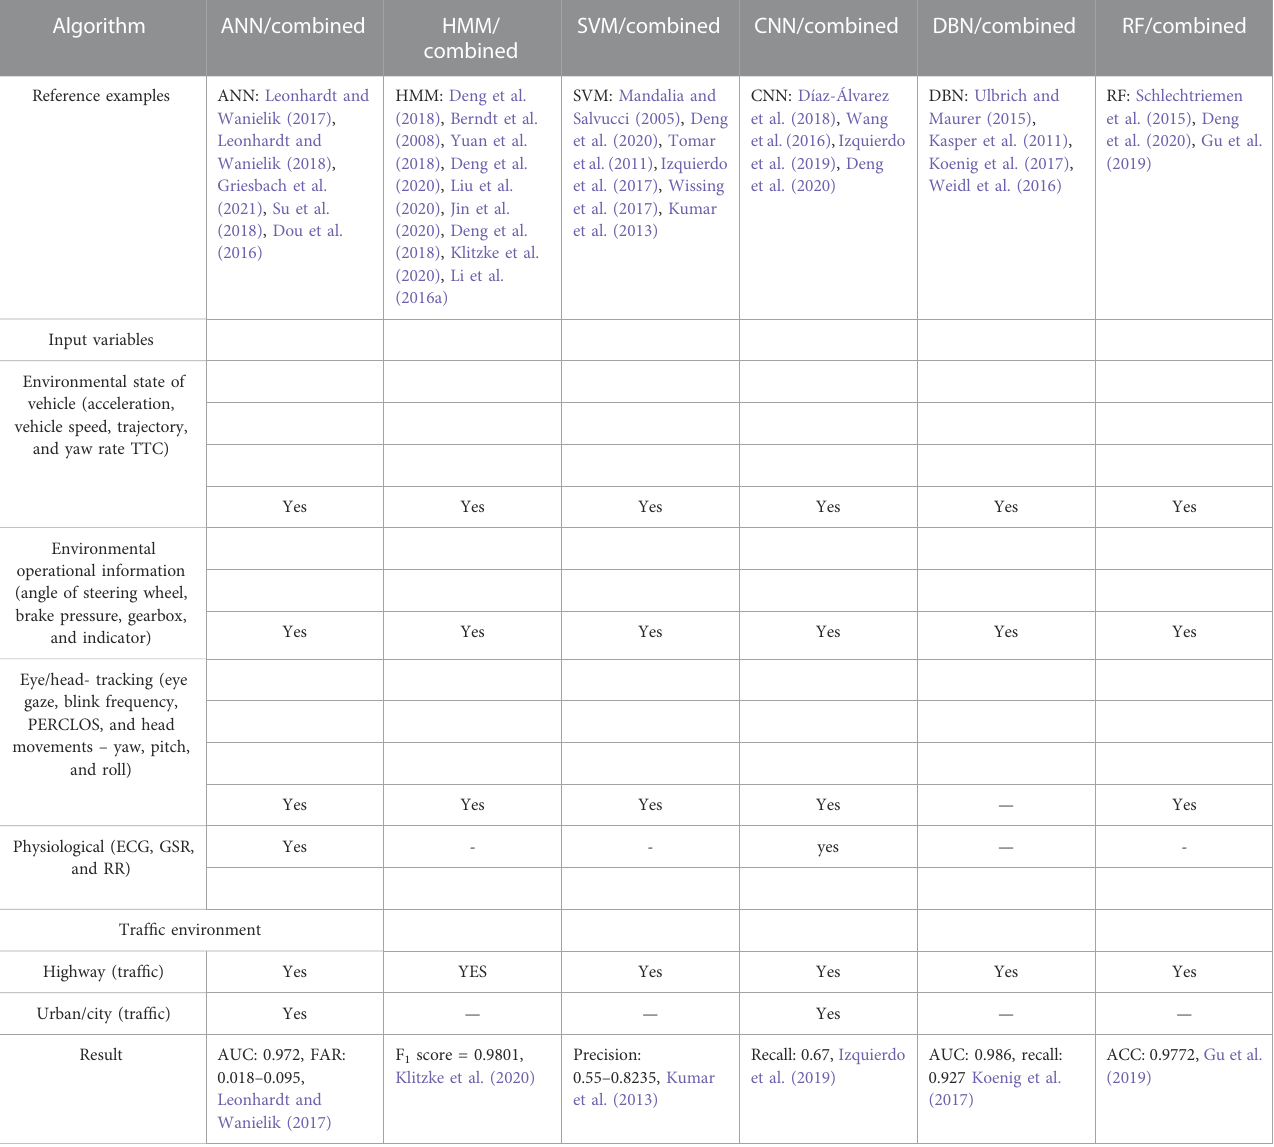
TABLE 7 Comparisons between different models for lane-changing behavior prediction and recognition.